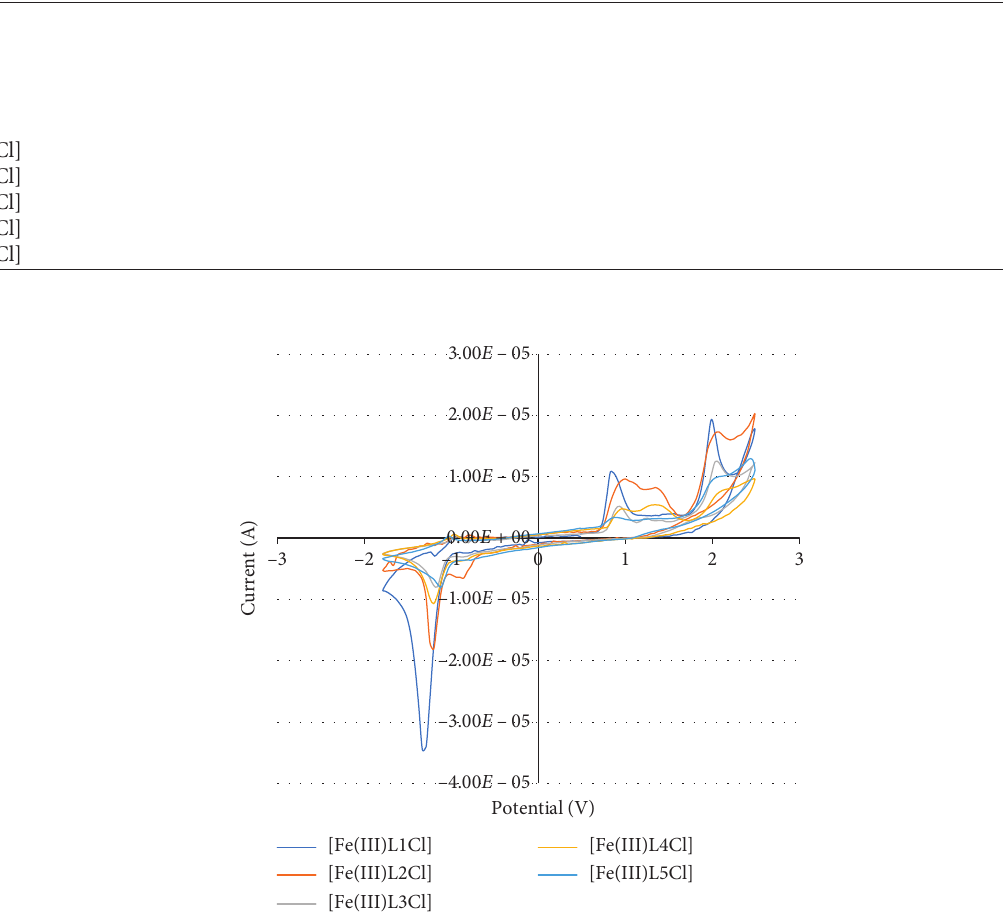
Figure 5: Cyclic voltammograms of unsymmetrical tetradentate Schiff base Fe(III)